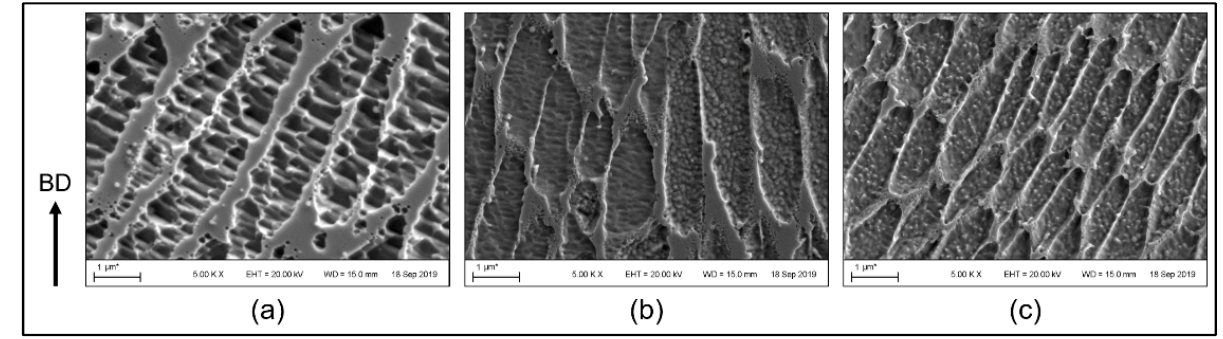
Figure 11. Substructures obtained on ( a ) L-PBF-1 (warm), ( b ) L-PBF-2 (mild), and ( c ) L-PBF-3 (cold). All L-PBF samples were cellular.